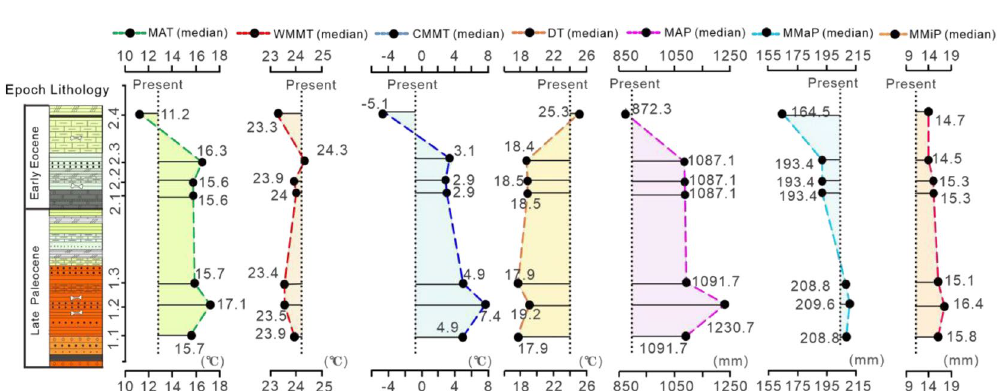
Figure 5. Comparison of the palaeoclimates of the seven periods (Periods 1.1–2.4) from the Late Palaeocene to Early Eocene and the current climate with median values (1.1–2.4: Periods